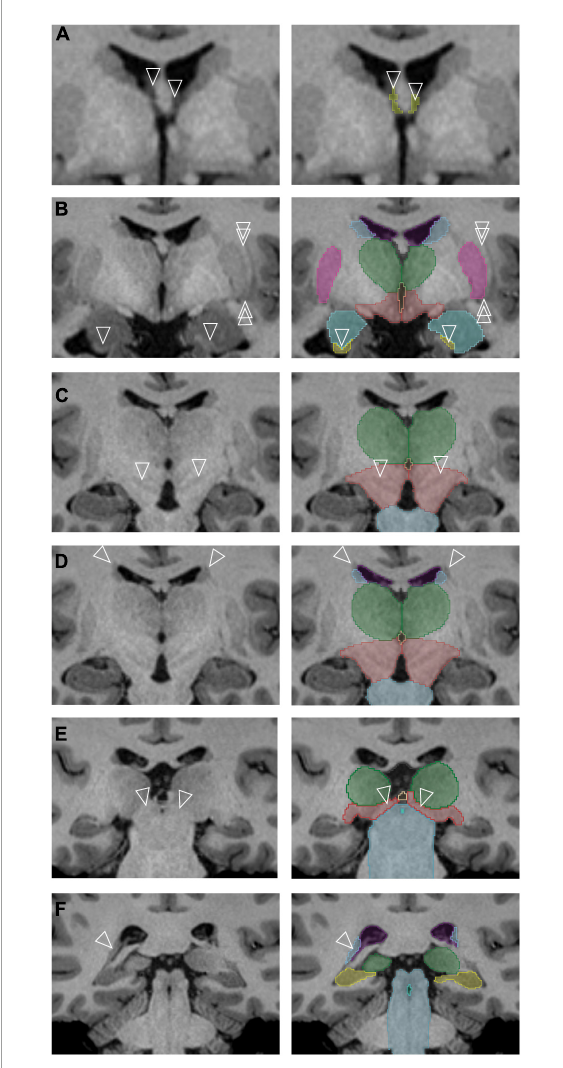
FIGURE6 Specific subcortical regions for which refinements of the neuroanatomical definitions originally used by the Center for Morphometric Analysis (CMA) were made. The left column contains unlabeled images, and the right column represents the corresponding images after segmentation. (A) The anterior portions of the transverse cerebral fissure (TCF) (arrowheads) are segmented as they separate along the columns of the fornix [cerebrospinal fluid (CSF) space of the TCF shown in yellow]. (B) The single arrowheads point to the anterior sliver of the hippocampal formation, definable by its white matter capsule. The double arrowheads indicate a thin white matter pathway that forms the lateral border of the putamen (pink) and is clearly observed in this dataset. The amygdala is shown in teal; the caudate, light blue; hippocampal formation, yellow; thalamus, green; ventral diencephalon (anterior portion), red. (C) Gray matter regions in the posterior ventral diencephalon (light red) are visible in the higher resolution dataset (arrowheads). The thalamus is shown in green; brainstem, light blue. (D) A white matter pathway superior and lateral to the caudate nucleus (blue) is indicated by the tips of the arrowheads. The thalamus is shown in green; ventral diencephalon (posterior portion), light red; brainstem, light blue. (E) The pretectal region (tips of